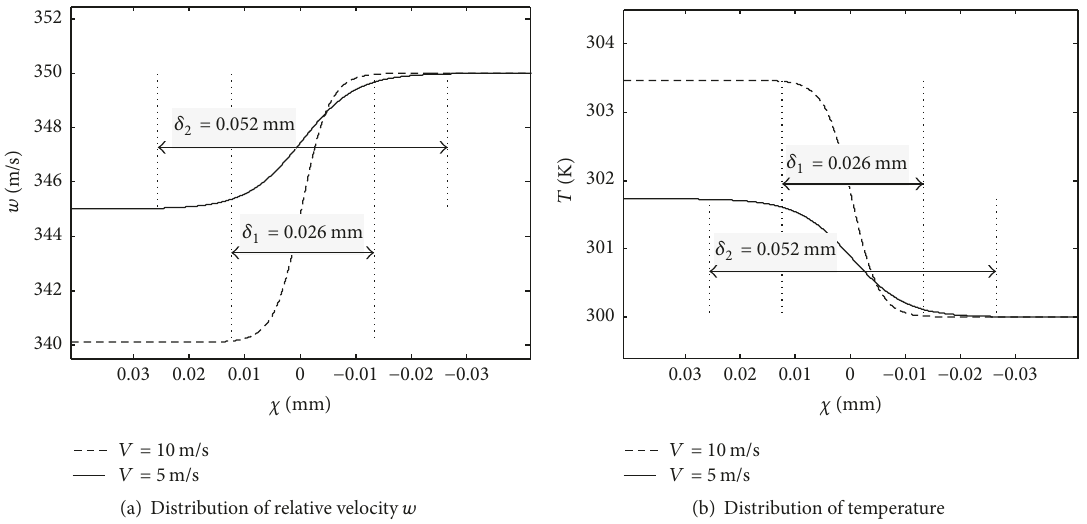
Figure 4: Distribution of relative velocity 𝑤 and temperature 𝑇 in the shock wave.